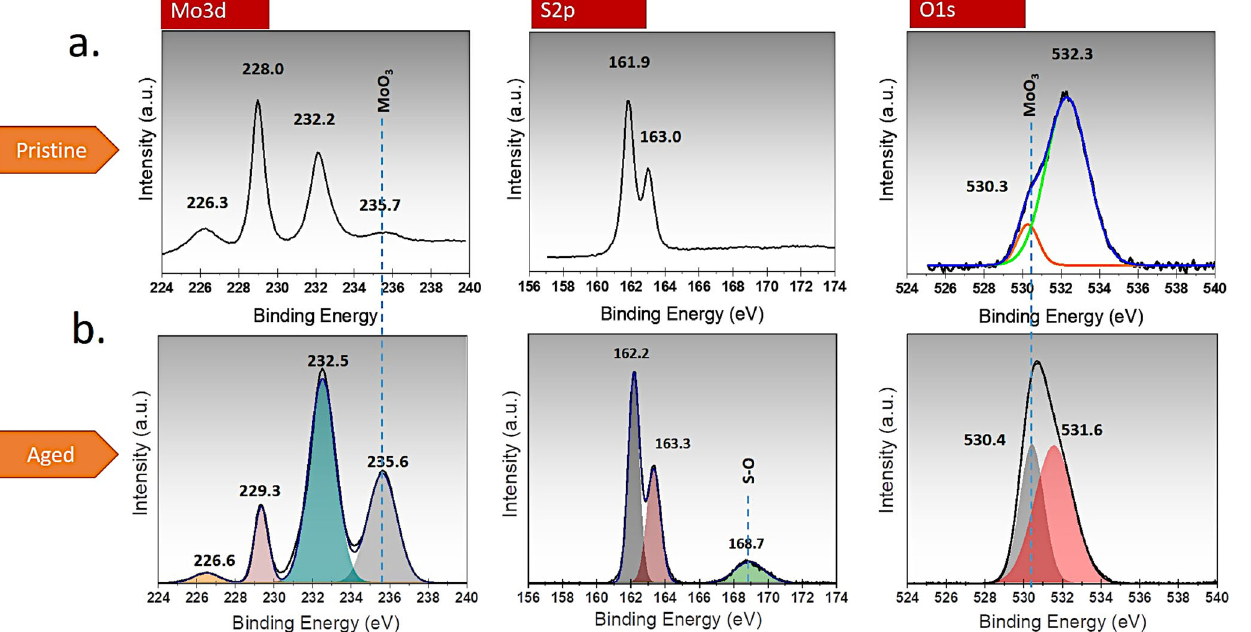
Fig. 5 XPS investigations of the pristine and long-term aged sample. a Mo 3d , S 2p and O 1s peaks shown respectively from left to right, for the pristine sample. b Same peaks shown for the aged sample ( ∼ 36 months).